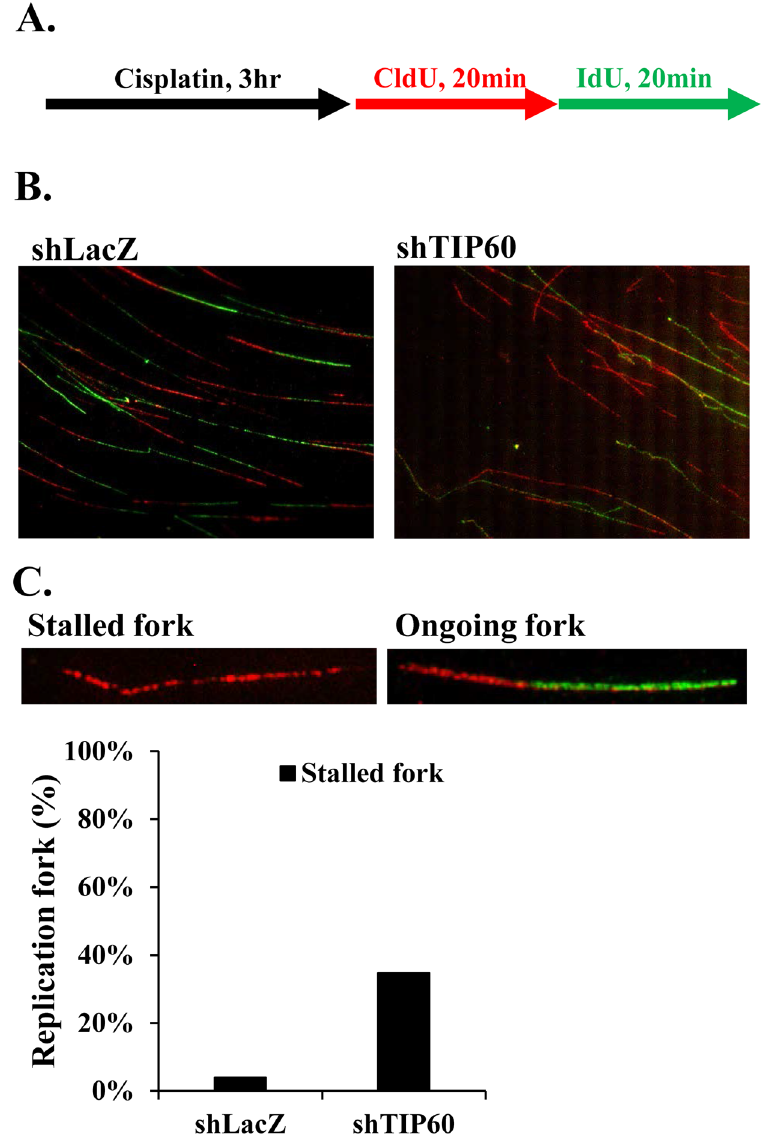
Figure 3. TIP60-deficient HONE6 cells show increasing frequency of stalled replication forks. ( A ) Labeling protocols for DNA fiber analysis. The HONE6 cells were treated with 10 μ M cisplatin for 3 hours, followed by pulse-labelled with CldU and IdU for 20 minutes each. CldU was detected using a specific primary antibody and an Alexafluor594-labeled secondary antibody (red). IdU was detected using a specific antibody and an Alexafluor488-labeled secondary antibody (green). Representative images of replication tracks of HONE6 were shown as indicated ( B ). ( C ) Quantification of stalled forks was determined from at least 100 DNA